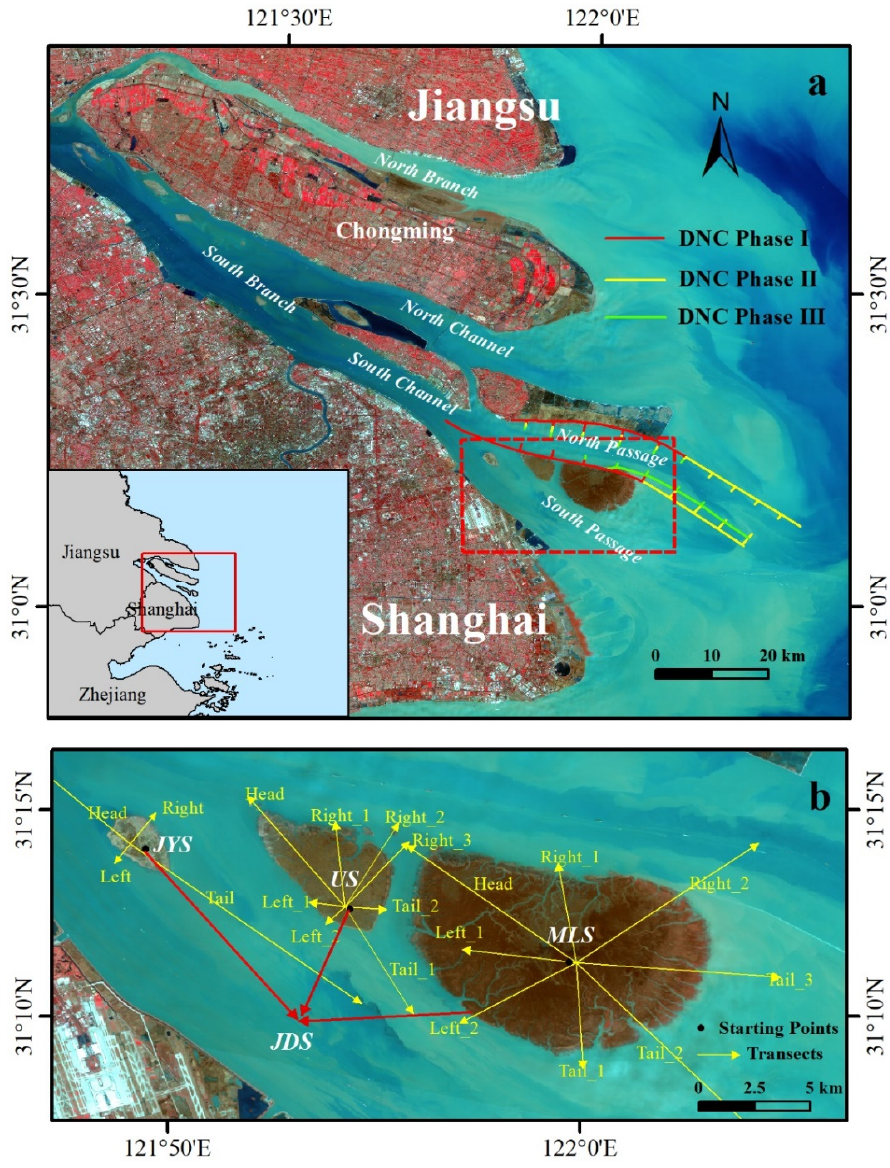
Figure 1. Location of the study area in the Yangtze Estuary. ( a ) Deep-water Navigation Channel project (DNC) in the North Passage. ( b ) Location of the 20 transects. The underlying image is a composite of 5-4-3 bands of the Landsat8 OLI data acquired on 22 February 2020.